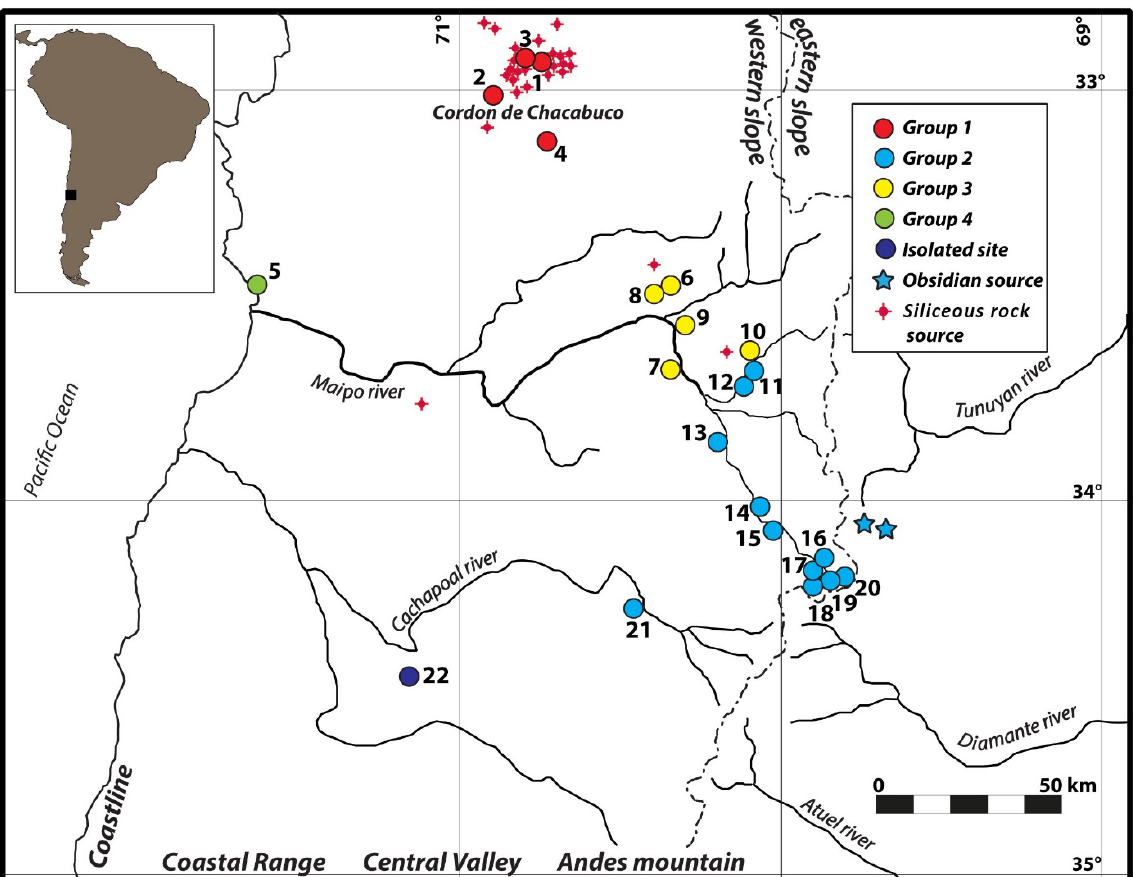
Figure 4. Spatial distribution of the sites classified according to the groups to which they